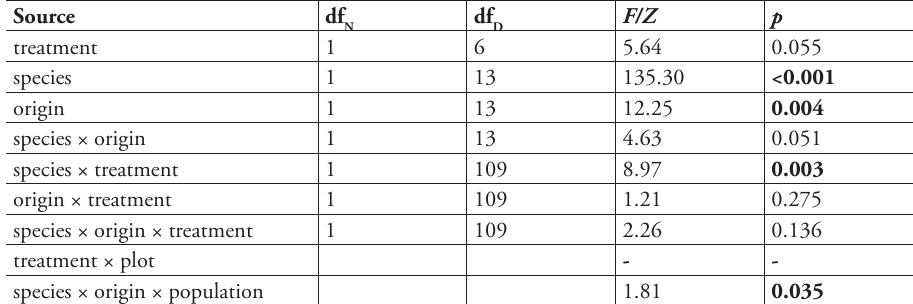
Table 3. Results of the mixed model analysis of the within-species approach testing for local adaptation. given. ‘Treatment × plot’ and ‘species × origin × population’ interactions were considered random effects and a Z-value instead of F-value is provided. Bold numbers indicate significant p-values ( p <